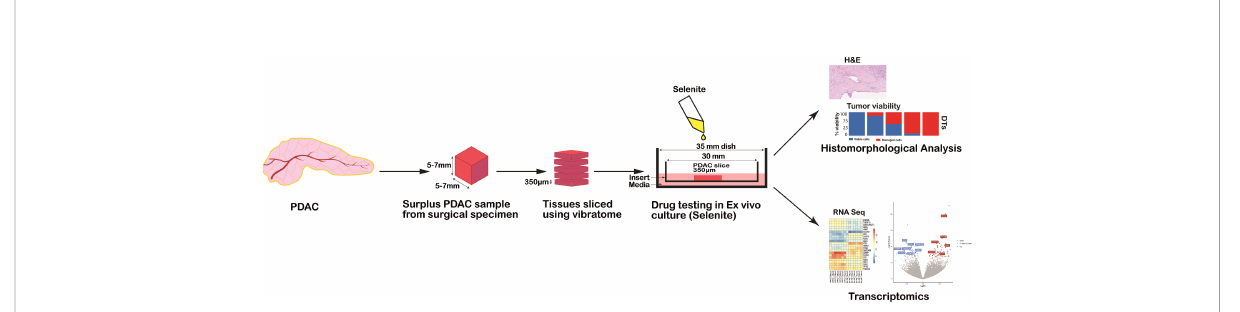
FIGURE 1 Schematic representation of the work fl ow for drug testing in PDAC ex vivo model from human surgical specimens.